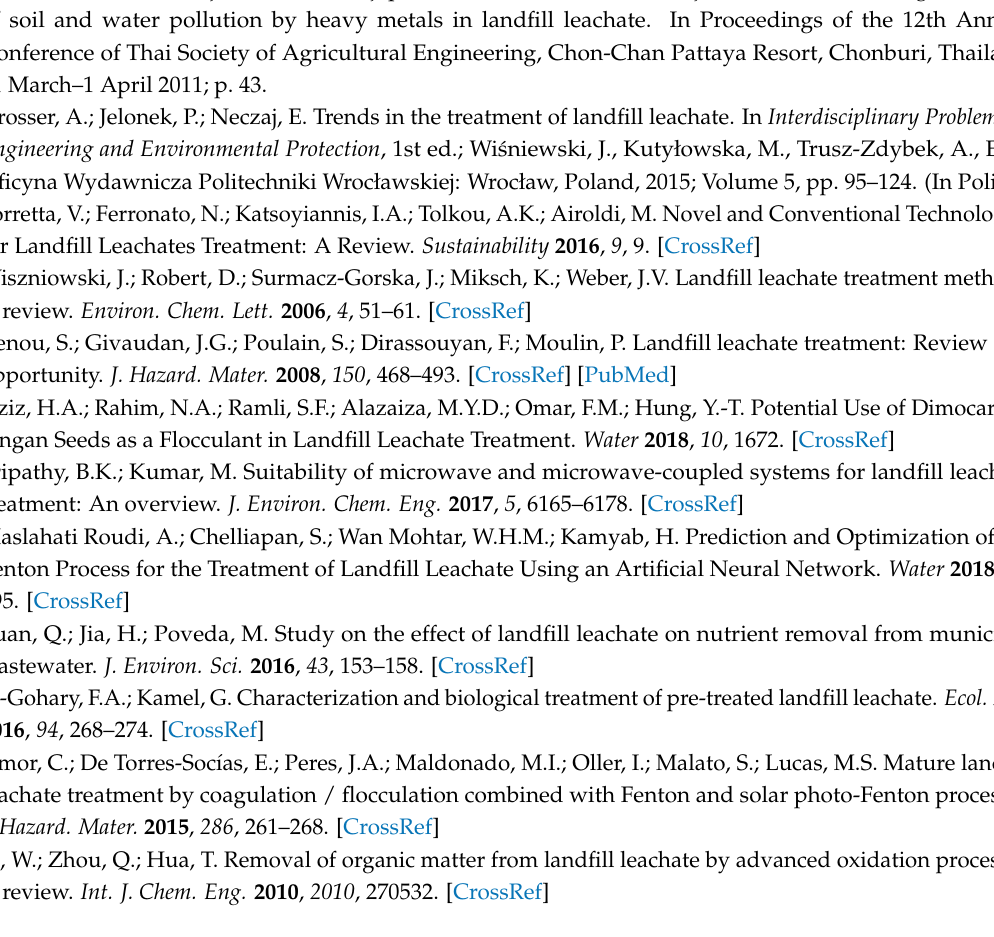
Figure S1: title, Table S1: title, Table S2: Results of Tukey HSD test; variable ∆ DHA activity. Author Contributions: The experiments were designed and carried out by E.N. who, in partnership with A.G., analyzed the acquired data, while M.M. contributed reagents and materials. A.G. carried out statistical analyses of the results and wrote the paper in consultation with P.C., who also performed linguistic and translation